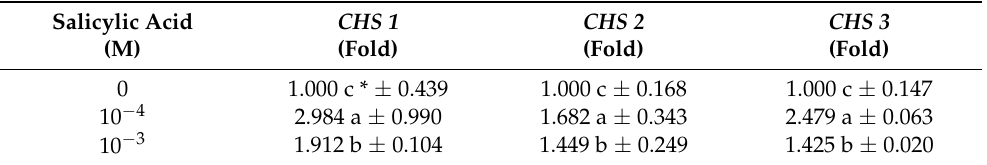
Table 6. Fold difference of CHS 1 , 2 , and 3 gene expressions as a result of salicylic acid treatments. In each treatment group, the mean was calculated from duplicate qRT-PCR data from six cDNA samples. Each cDNA sample was amplified from a total RNA sample isolated from a single